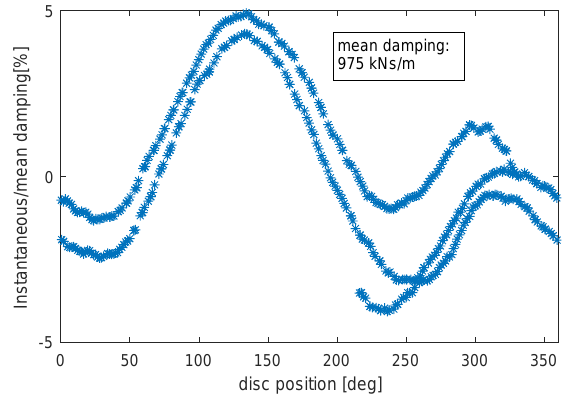
Figure 3. Instantaneous damping related to the mean damping, plotted over the disc position. The calculation is based on the disc rotational velocity after reaching constant velocity while a force of 12.5 N (model scale) is acting on the line. Mean damping is full scale equivalent. Graph shows one test with 2.25 revolutions.